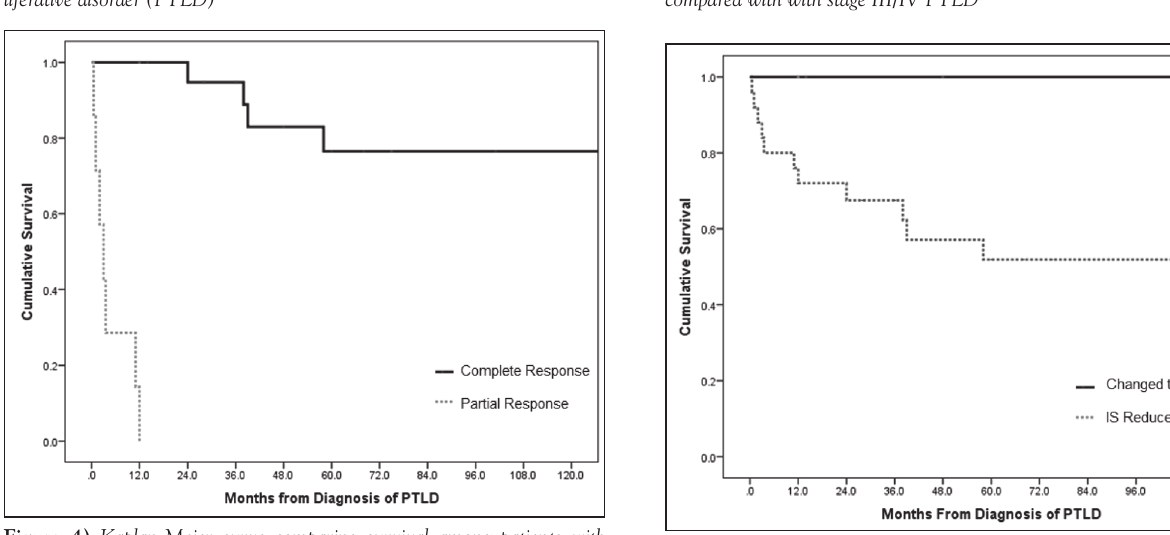
Figure 6) Kaplan-Meier curve showing comparing changing immunosup- pression (IS) to sirolimus approach with decrease in IS/stopping IS. PTLD Post-transplant lymphoproliferative disorder